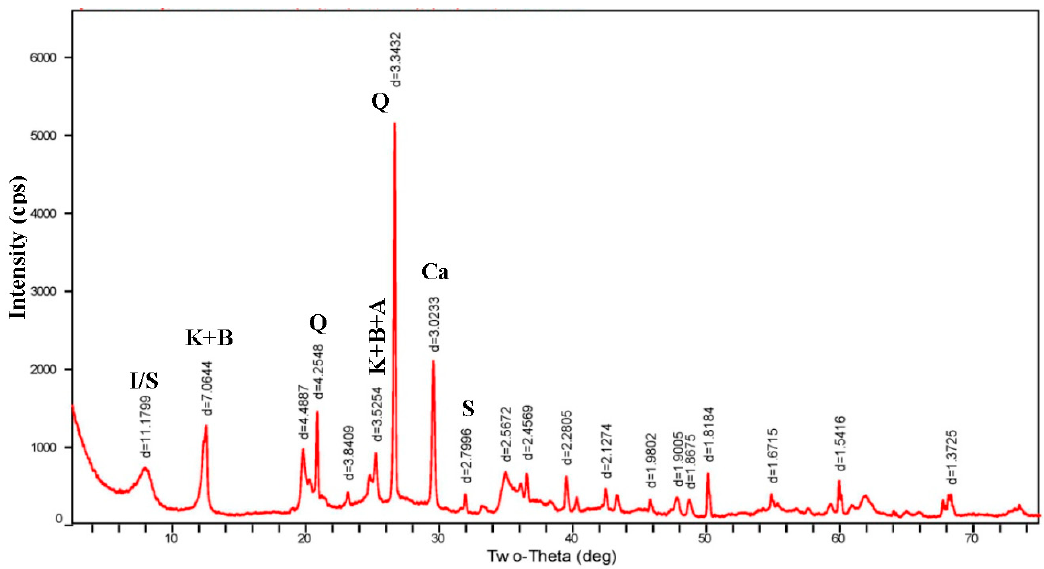
Figure 3. XRD of a selected sample (X-16). Abbreviations in the figure indicate the minerals identified, such as I/S: mixed layer illite/smectite; K: kaolinite; B: berthierine; Q: quartz; A: anatase; Ca: calcite; and S: siderite.